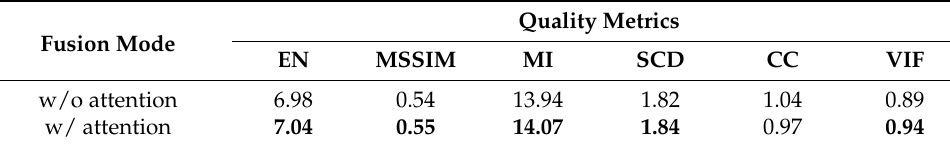
Table 2. Ablation study on the effectiveness of attention mechanisms in the feature fusion module. Bold represents for the best result in